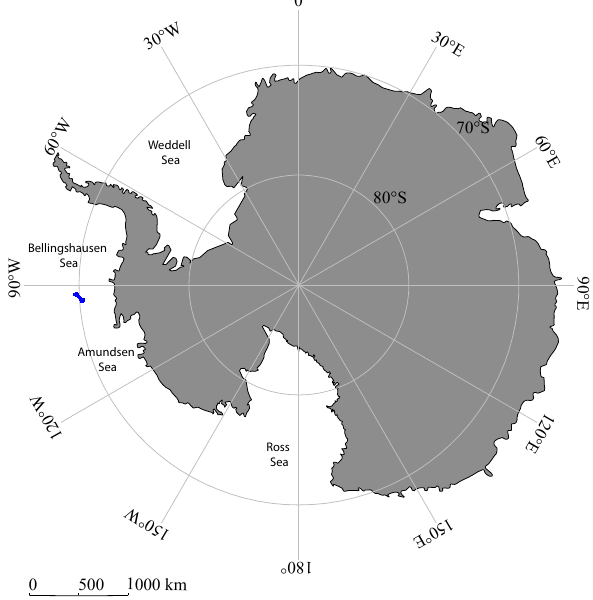
Figure 1. Location of the sampling area for the SIMBA cruise 2007 (blue patch), in the Bellingshausen Sea,